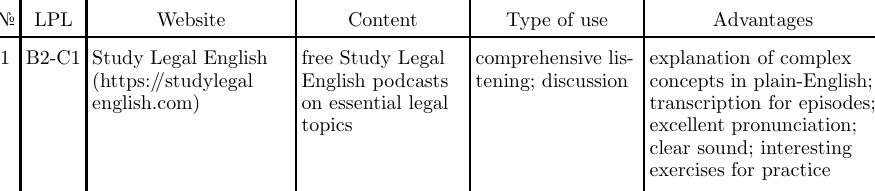
Open Online Educational Resources for Law: